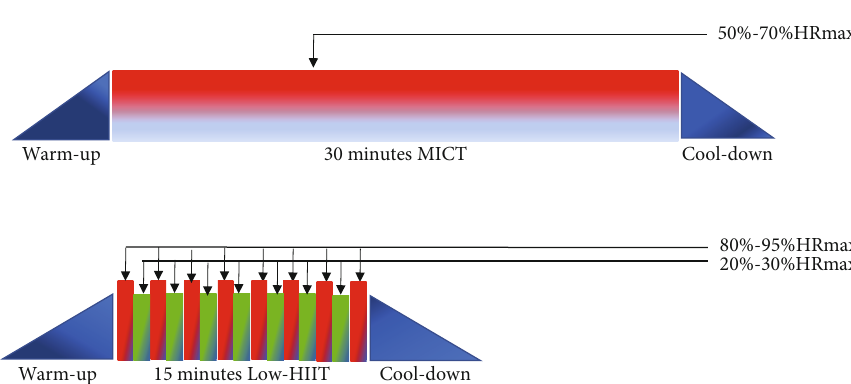
Figure 2: Schematic diagram of the two exercise